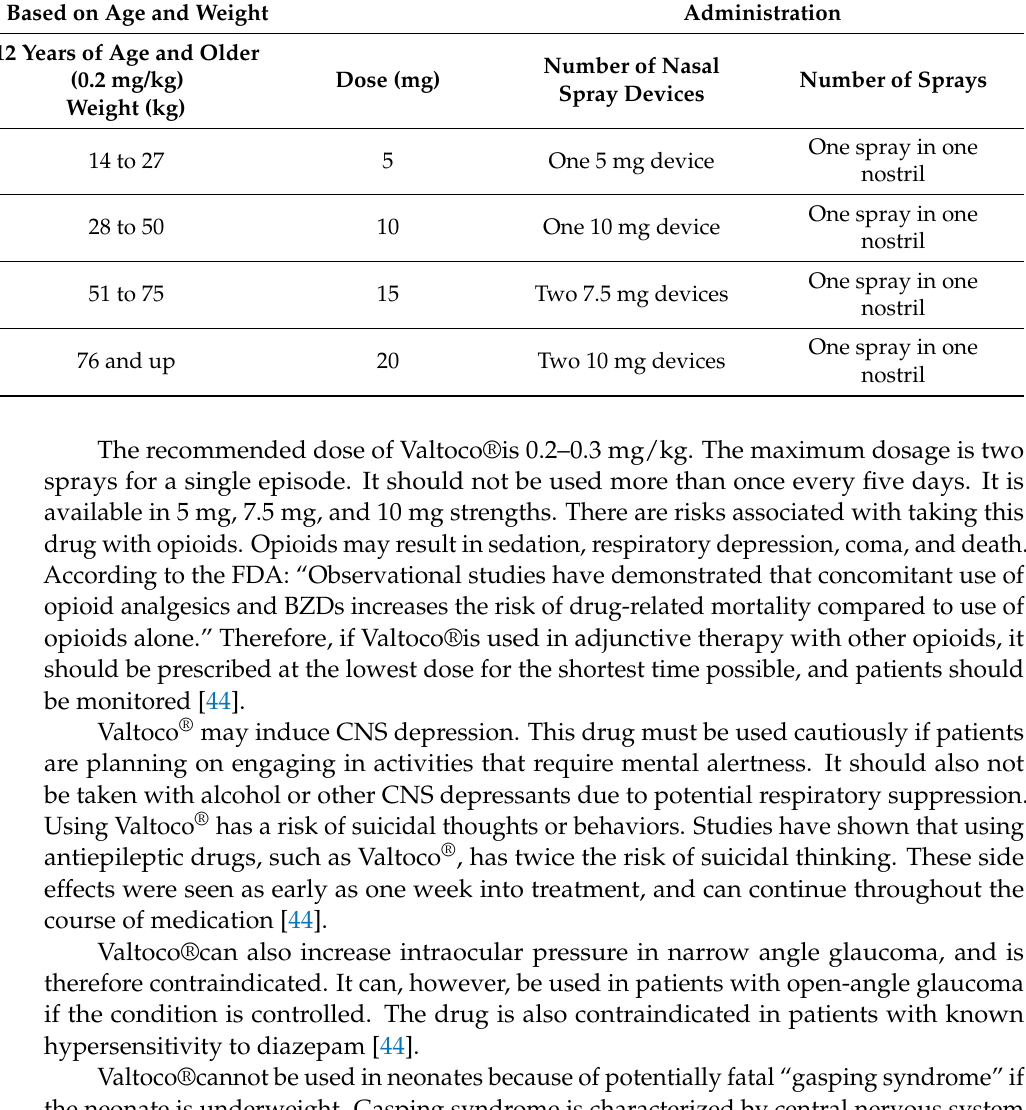
Table 1. Recommended dosage for adults and pediatric patients six years of age and older. Dose Based on Age and